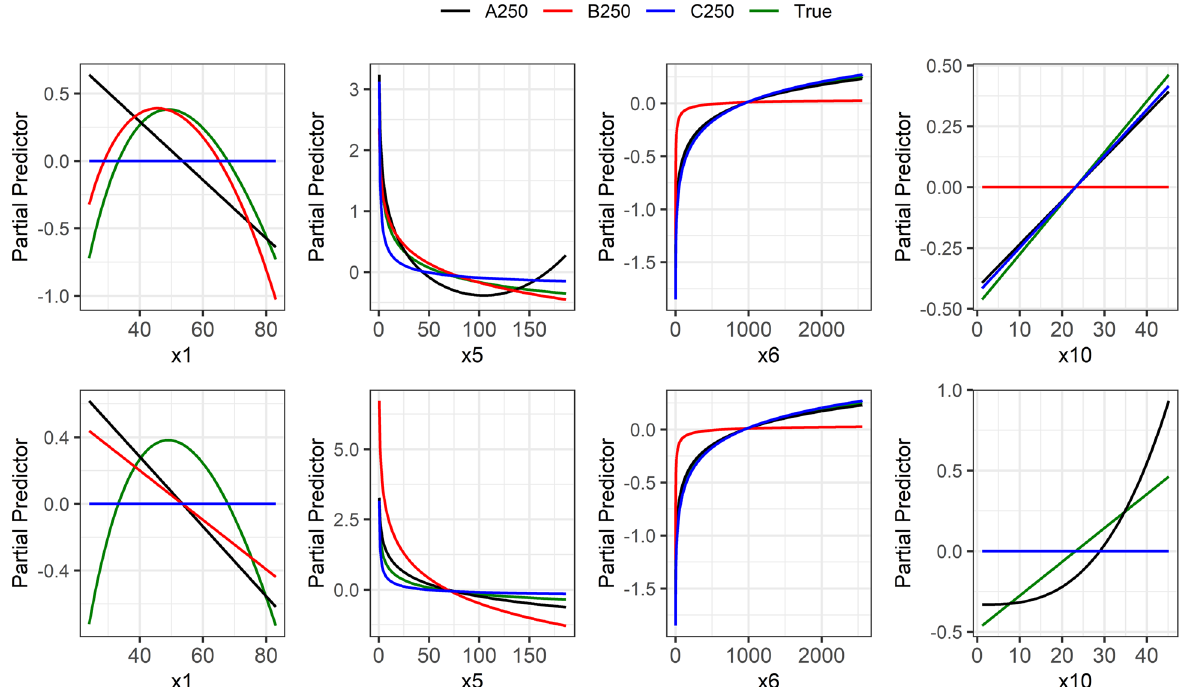
Fig. 6 Data A250, B250, and C250. Functional forms of continuous variables for the selected MFP models (see Table 3). The upper panel shows the plots from complete data, while the lower panel shows the plots after the removal of IPs. The horizontal line indicates that no variable was selected. Not shown are x3 (linear in true and A250, out in B250 and C250) and x7 (true out and never